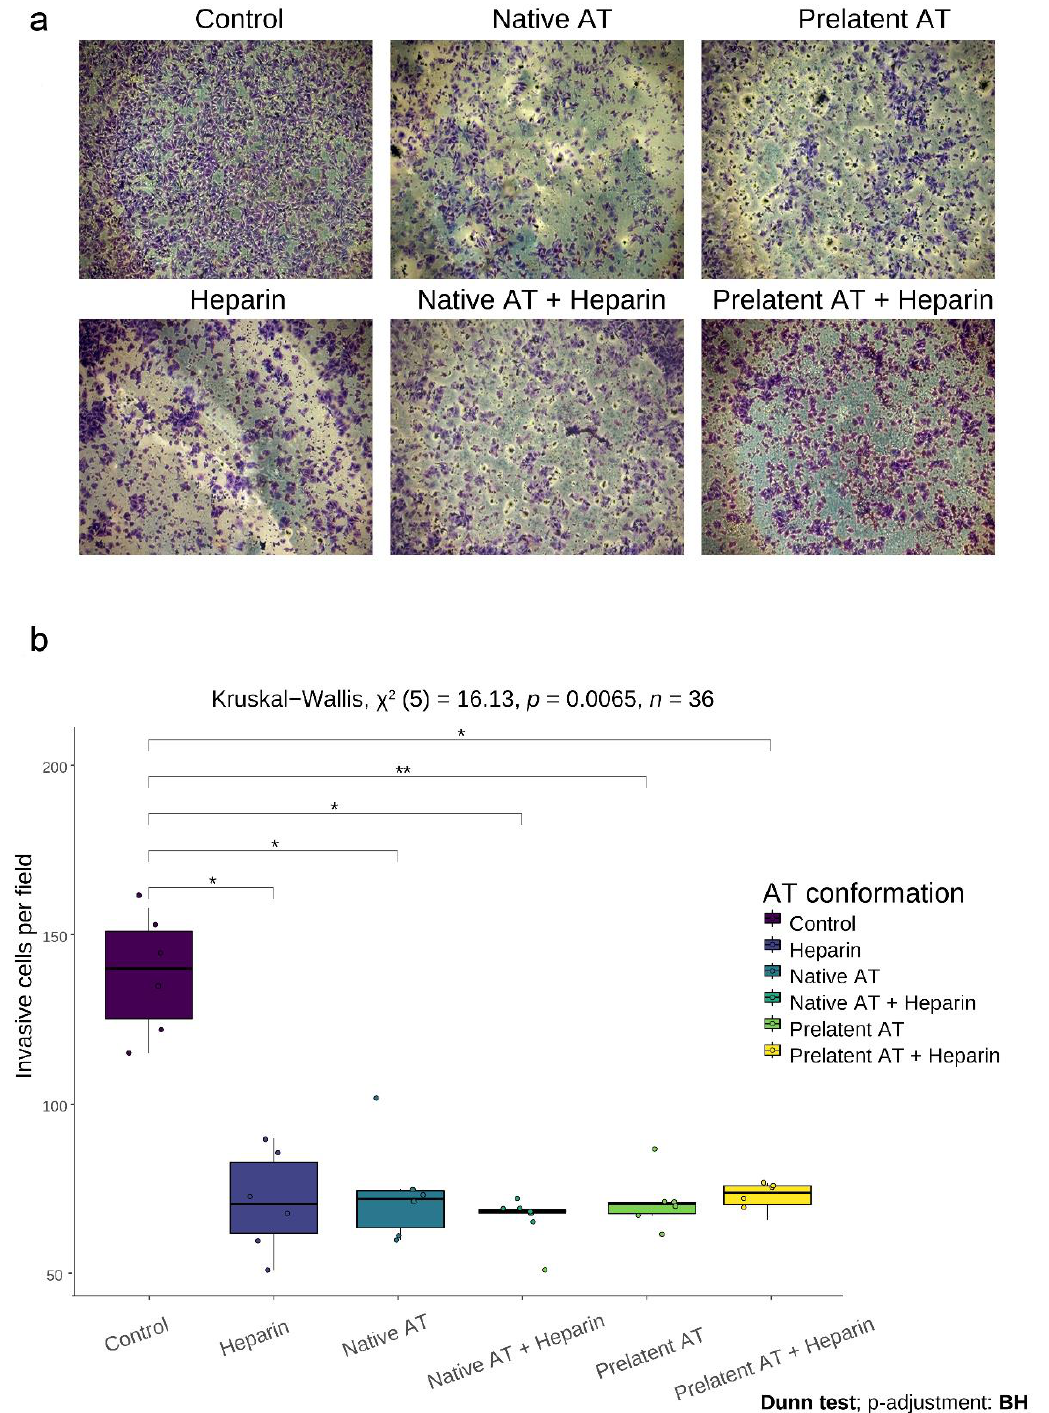
Figure 4. Effects of antithrombin on invasion by transwell assay. Cell invasion was evaluated after incubation of U-87 MG cells for 6 h with no treatment (control), low molecular weight heparin (LMWH), native antithrombin (AT), or prelatent AT, and each AT in combination with LMWH. ( a ) Microscope images of cells invaded after 6 h of incubation. ( b ) Percentage of cells invading under the different conditions. Each condition was evaluated in triplicate, and 3 different images were processed for each assay; * p < 0.05; ** p < 0.01. Images were recorded with a Leica microscope at 5 × , and Fiji-ImageJ was used to analyze invasion. Abbreviations: BH = Benjamini–Hochberg procedure; AT = antithrombin.